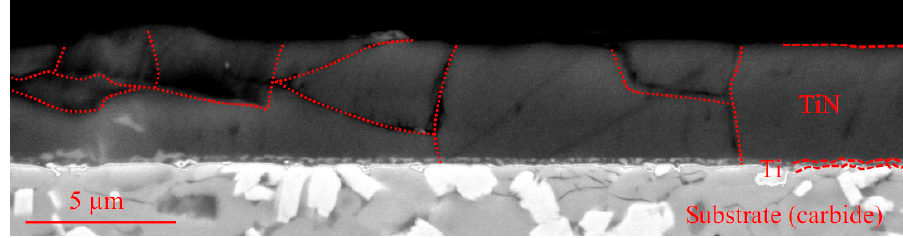
Figure 17. Mechanism of wear and failure for a cutting tool with coating S1 (Ti–TiN). Turning of steel